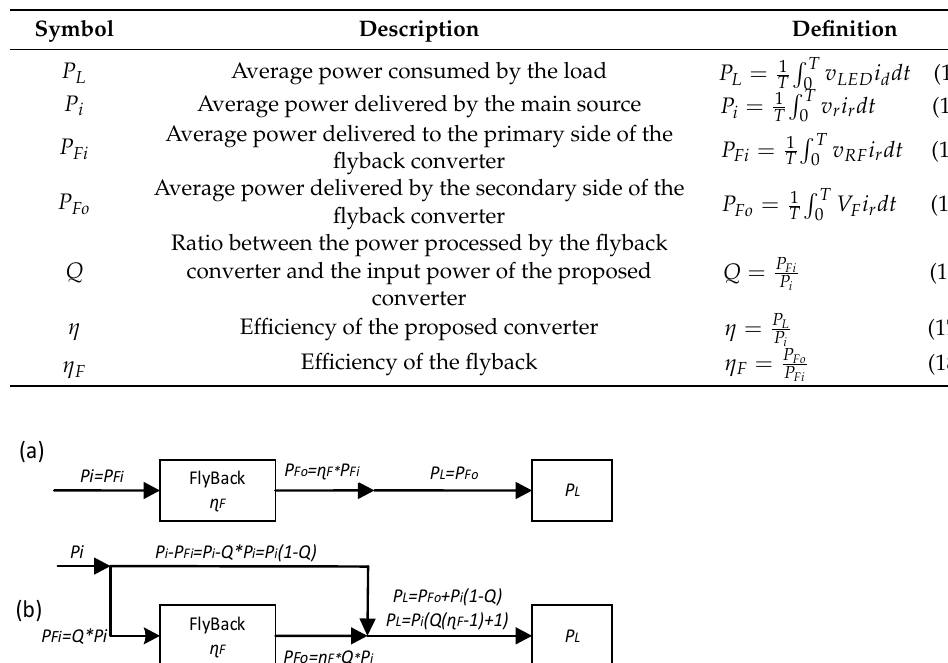
Table 1. Power flow concepts.